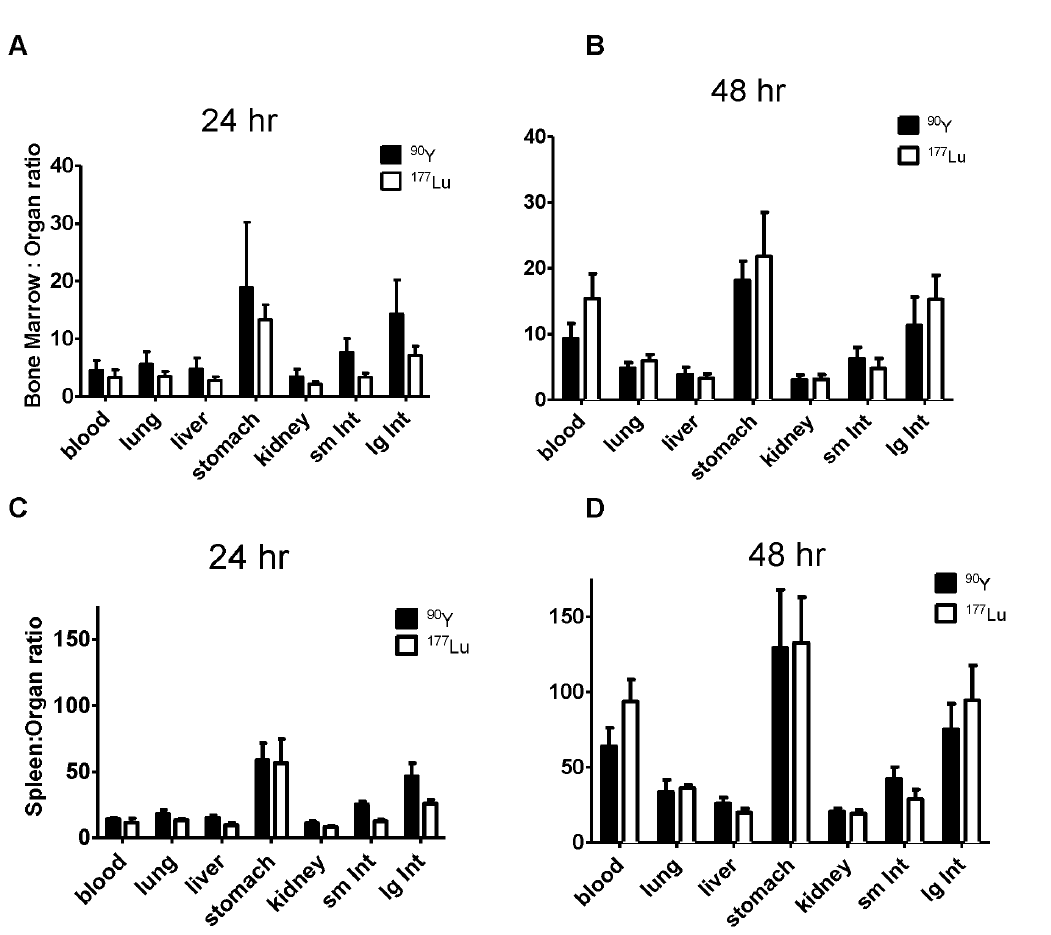
Figure 2. Target-to-Normal Organ Ratios. Mean ratios of radioactivity uptake for 90 Y-DOTA-30F11 ( & ) and 177 Lu-DOTA-30F11 ( % ) delivered to BM ( A and B ) or spleen ( C and D ) compared to normal organs at 24 and 48 hours.